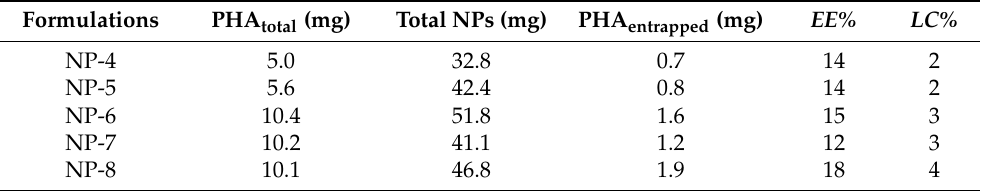
Table 2. Encapsulation efficiency and loading capacity of PLGA (poly (lactic-co-glycolic acid)) nanoparticles.